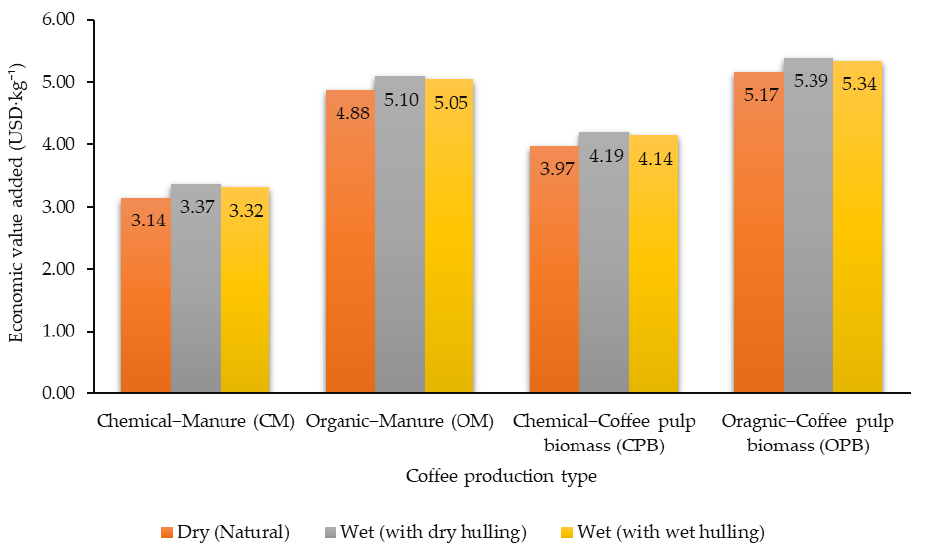
Figure 8. Value added in the life cycle of 1 kg of coffee green beans.